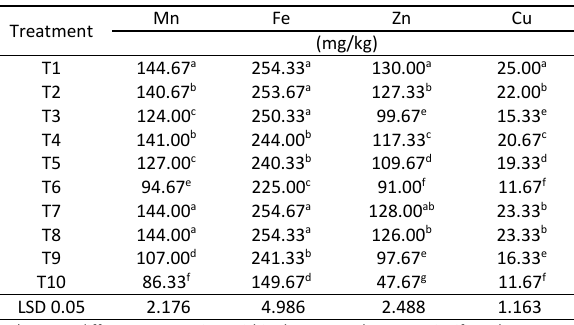
Table (6): Effect of biofertilizers on micronutrients in celery Table 6. Effect of biofertilizers on micronutrients in Treatment